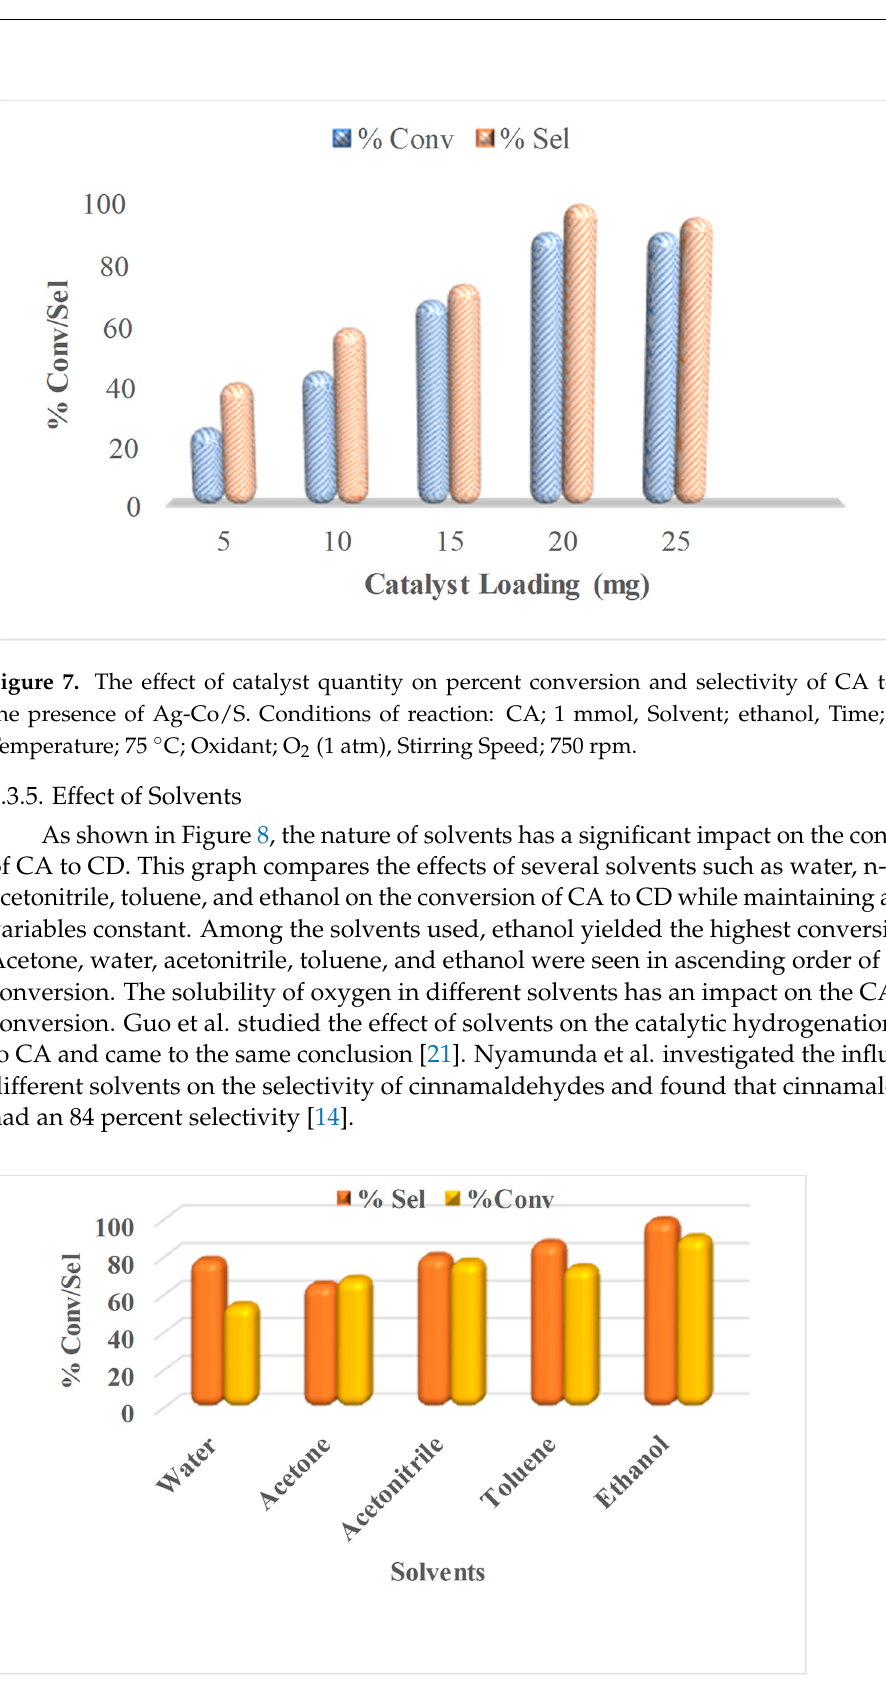
Figure 8. The effect of various solvents on percent conversion and selectivity of CA to CD in presence of Ag-Co/S. Conditions of reaction: Cat; 25 mg, CA; 1 mmol, Solvent; ethanol, Oxidant; O 2 (1 atm), Time; 80 min, Stirring speed; 750 rpm, Temperature; 75 °C.